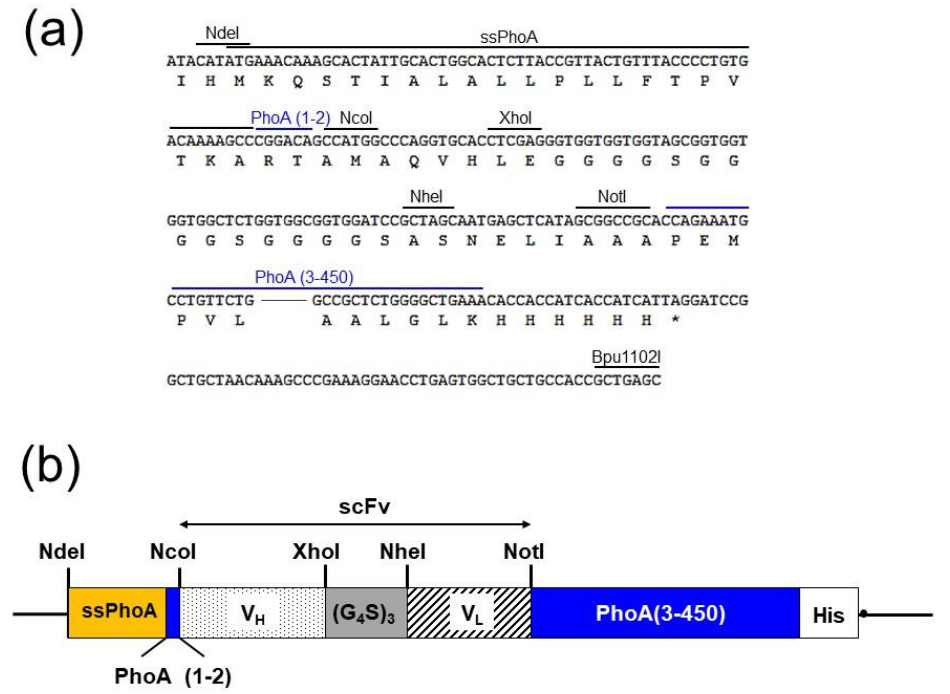
Figure 2. ( a ) Partial sequence of pET-NXNN-PhoA shown together with the cloning site and the restriction sites used in the cloning strategy. ( b ) Schematic representation of scFv cloned into pET- NXNN-PhoA. Orange square, signal sequence for PhoA (ssPhoA); blue square, two N-terminal amino acids of PhoA (PhoA (1-2)); dotted rectangle, heavy-chain variable domain (V H ); gray square, linker ((G 4 S) 3 ); striped rectangle, light-chain variable domain (V L ); blue rectangle, PhoA (3-450); white square, His-tag; black circle, stop